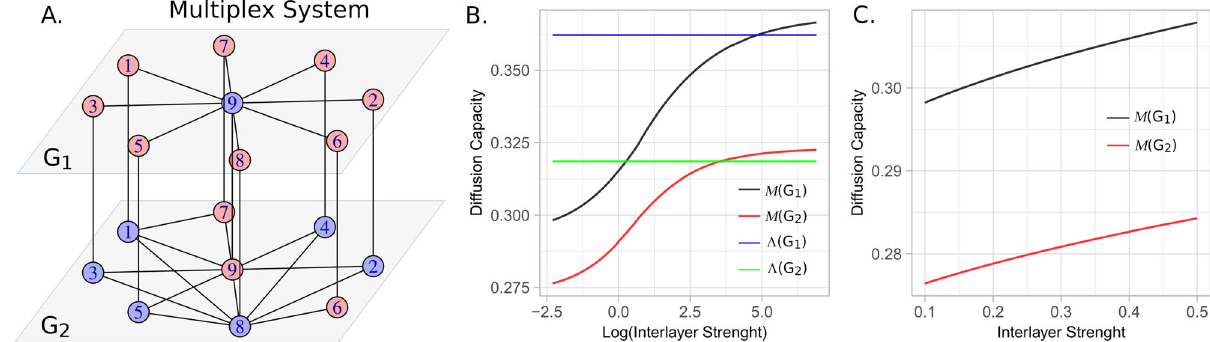
Fig. 4 | Multiplex network formed by layers G 1 and G 2 connected by weighted links with equal interlayer strength. Nodes in blue/red represent those that decrease/increasetheirdiffusioncapacityinthefullycoupled multilayerstructure, compared to their diffusion capacity in isolation ( A ). Diffusion Capacity Λ of G 1 , G 2